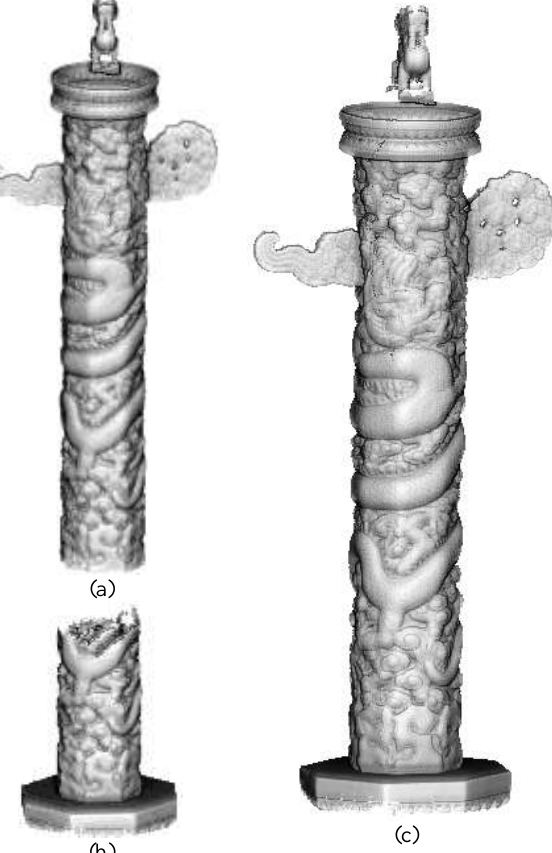
Figure 4. Point clouds of (a) Riegl VZ-100, (b) Mantis Vision F5 and (c) registered of above two point clouds The differences of spatial resolution and accuracy between two instruments were described in the previous section. The experimental result also revealed these